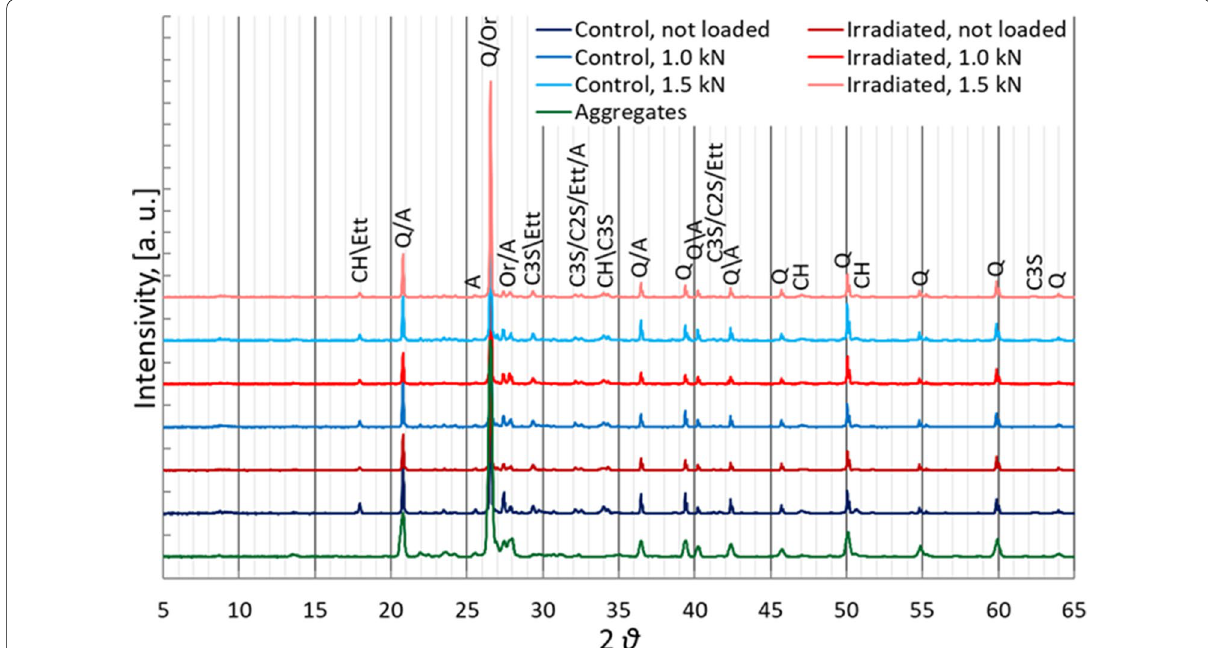
Fig. 9 Sample and aggregate diffraction patterns (C3S: alite; C2S: belite CH: portlandite; Ett: ettringite; Q: quartz; A: albite; Or: